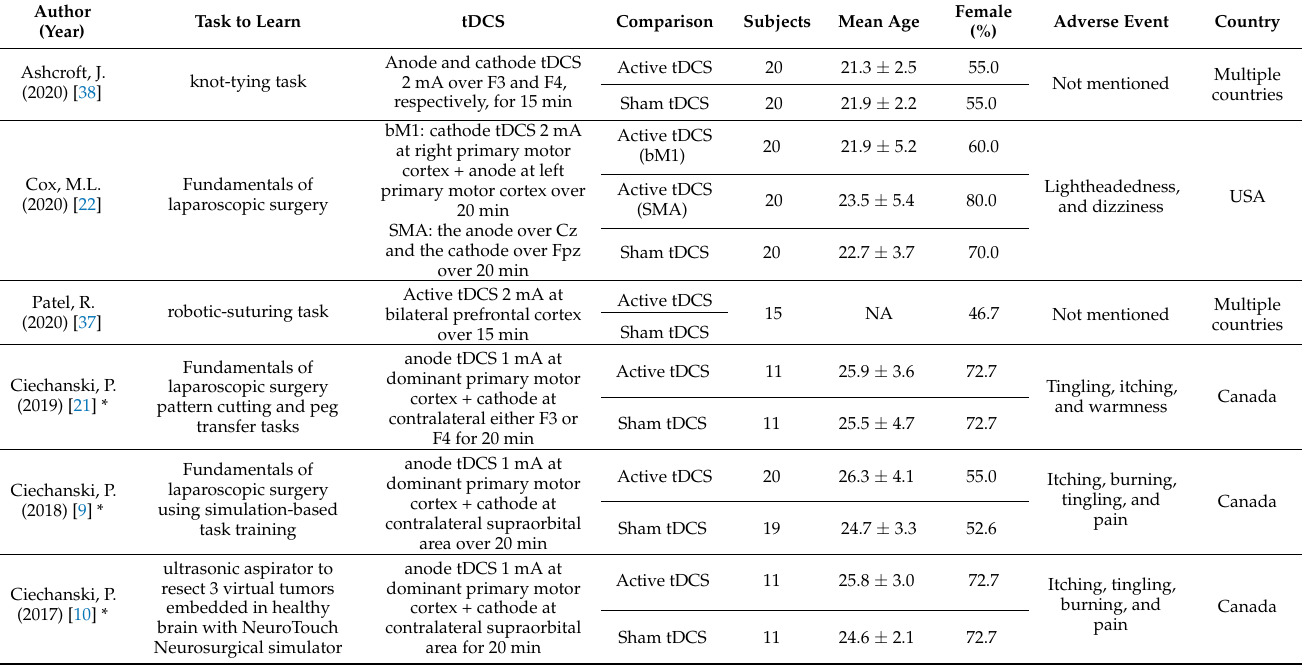
Table 1. Characteristics of the included randomized controlled